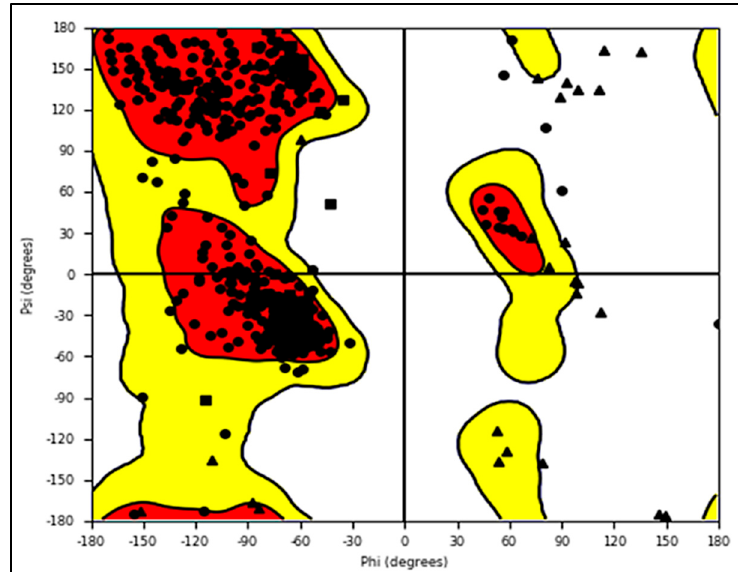
Figure 27. Ramchandran plot for LSD1 receptor.